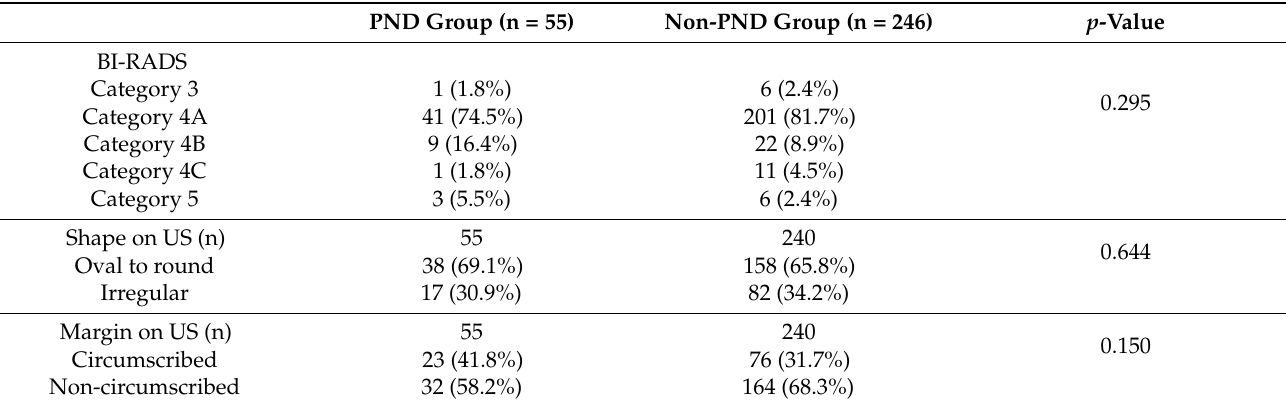
Table 5. Imaging characteristics of papillary lesions, classified according to pathologic nipple